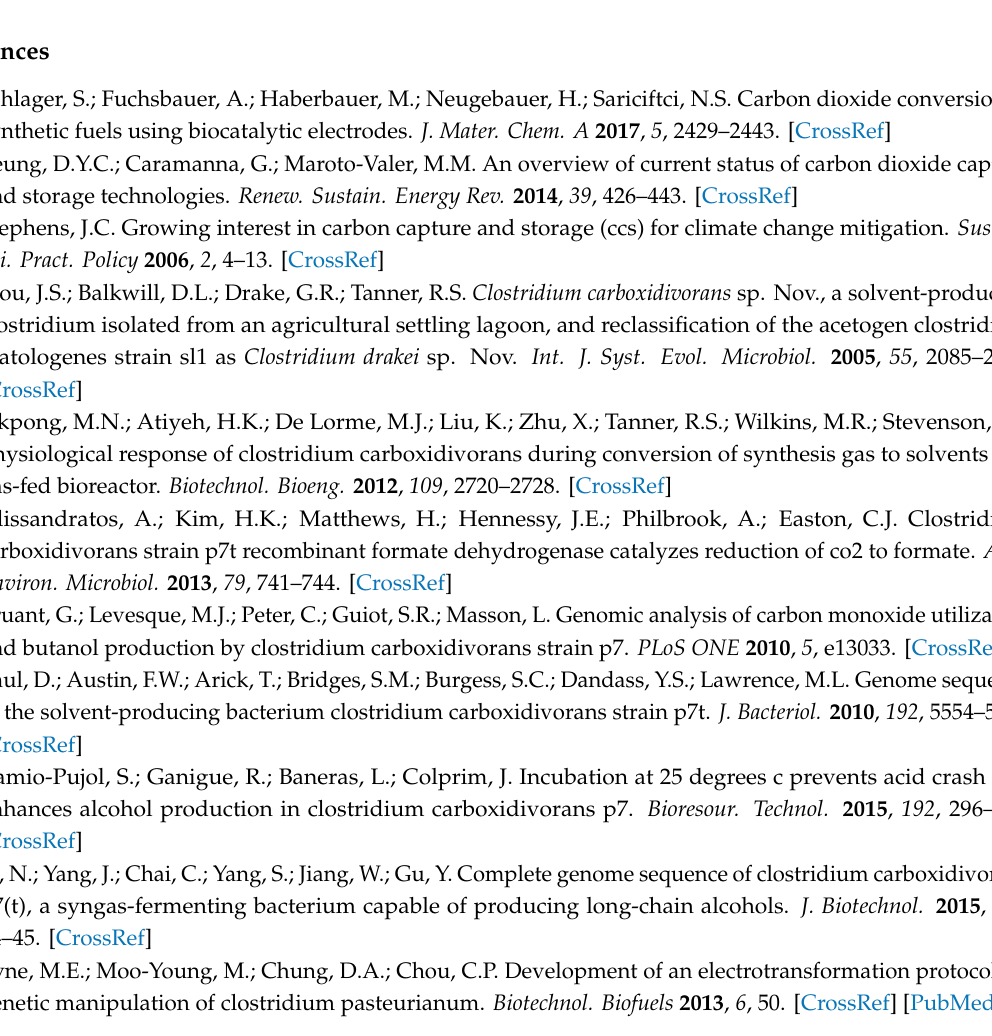
Figure S1. Comparison of growth of the wild type P7 in the WC medium (A) and the 1754-B medium (B). The P7 performed better at 25 ◦ C than at 37 ◦ C in both WC and 1754-B medium. Figure S2. Calibration curves of (A) Formic acid, (B) Acetic acid, (C) Ethanol, (D) Butyrate acid, and (E) Butanol. Equation and R2 are shown, ( R > 0.99). Equations were used to calculate the P7-WT and P7-EMS mutant end products corresponding to each retention time detected by HPLC. The X-axis corresponds to the di ff erent concentrations used, the Y-axis corresponds to the peak area detected by HPLC. Figure S3. Comparison between the end products identified for the wild type P7 when grown in the 1754-B defined medium on day